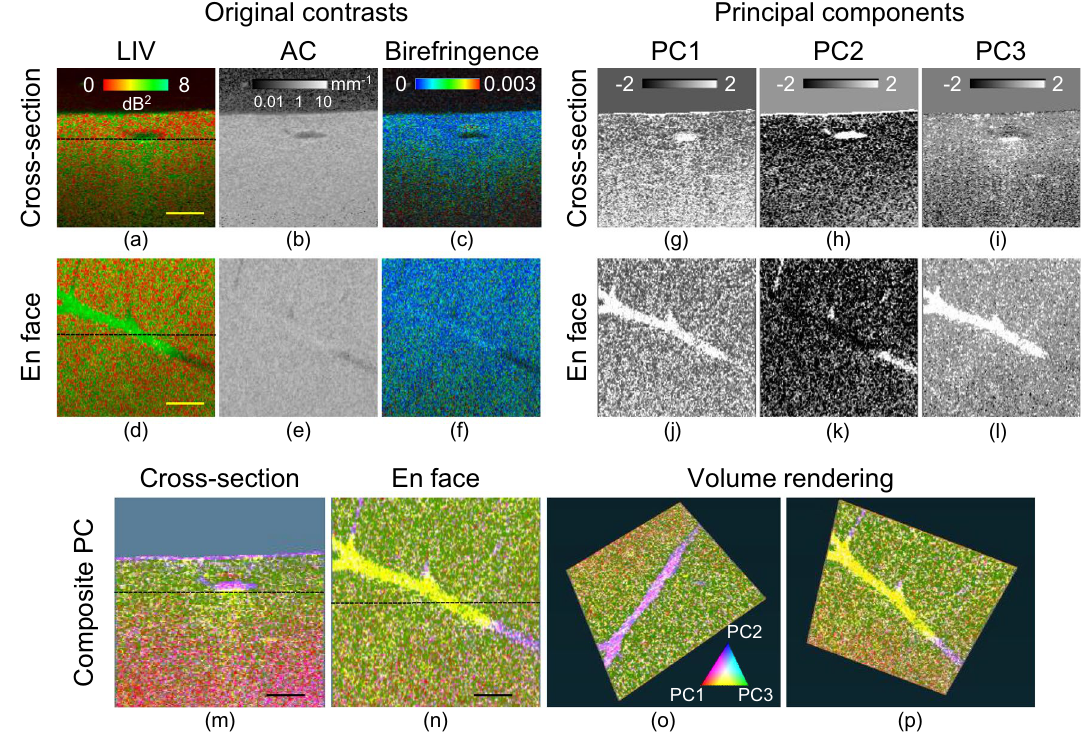
Figure 3. Principal component analysis of healthy mouse liver at 0 h time point. ( a – f ) Multi-contrast cross- sectional and en face images of the input features, including AC, LIV, and birefringence. ( g – l ) Cross-sectional and en face images of the principal components (PCs). ( m – p ) The composite PC (bottom row) is generated by assigning the red channel to PC1, the blue channel to PC2, and the green channel to PC3. Scale bar: 250 μm.